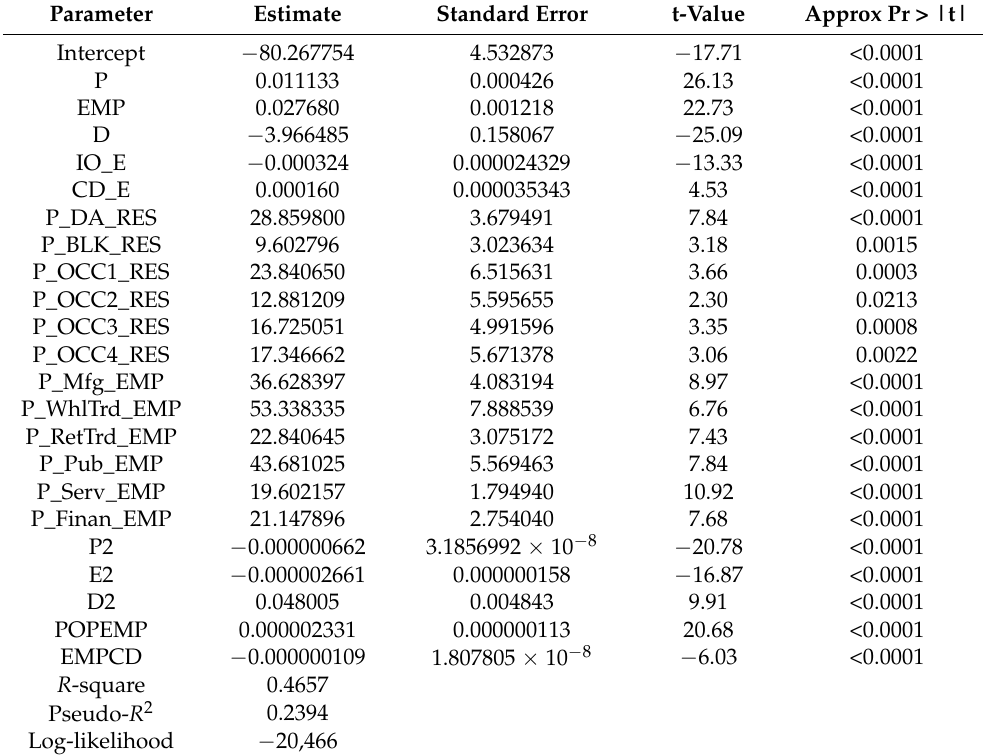
Figure 6. After initial exploratory modeling, the scenarios L1 and L5 were discarded as too restrictive and too unconstrained, respectively. The Scenarios L2 and L4 were then retained as sufficiently contrasted scenarios to provide insights into the impact of land availability. Table 9. Tobit Parameter Estimation of Model 4.